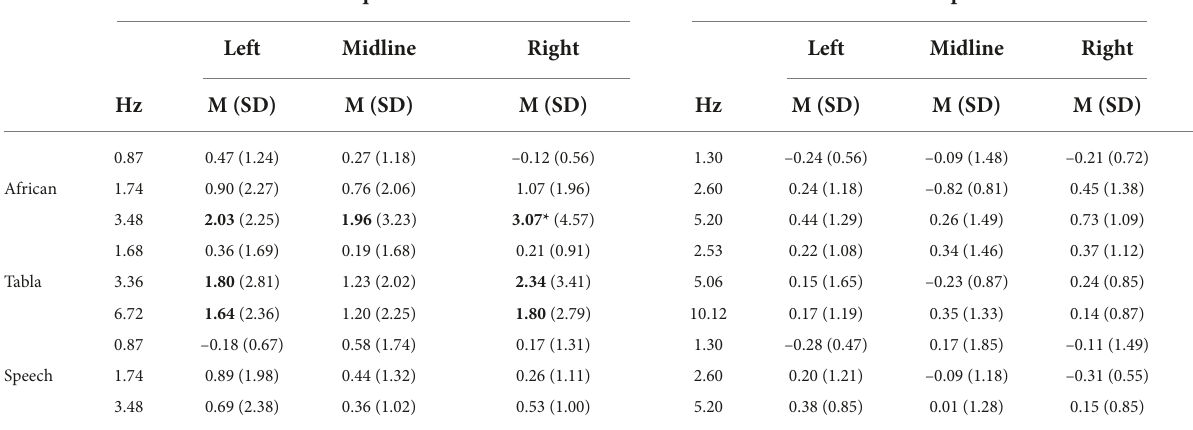
TABLE 1 Descriptive statistics: Mean (Standard Deviation) on SS-EP magnitudes for frequencies of interest vs. noise floor separated for sound stimuli and cluster of